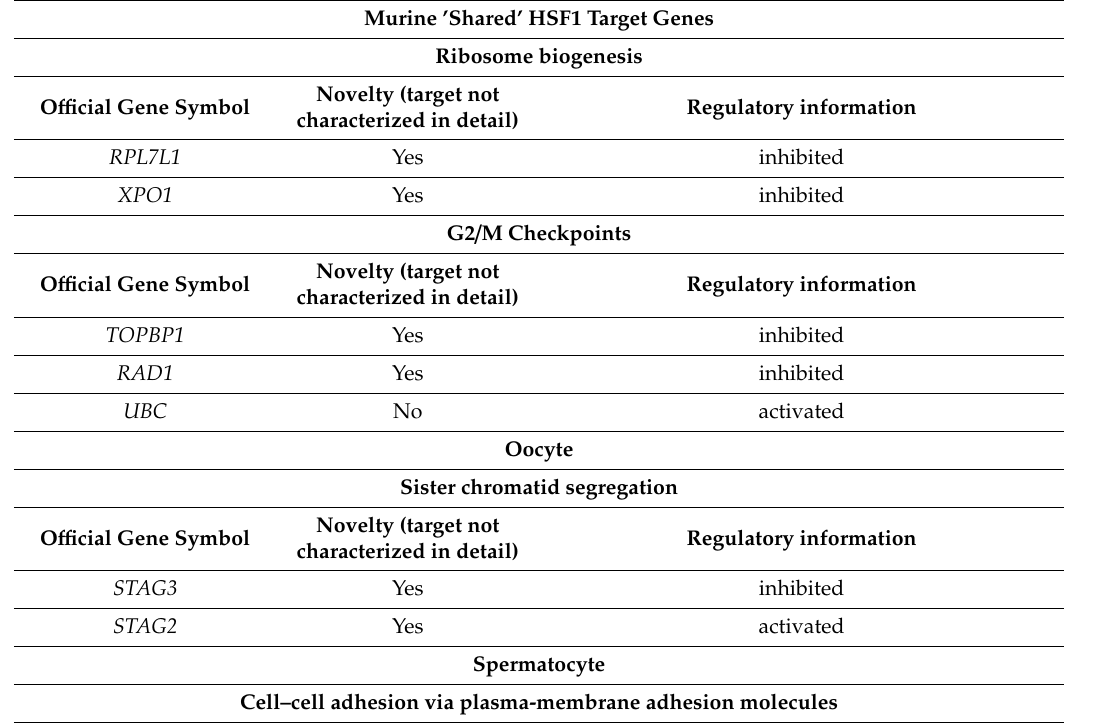
Table 3. Selected list of HSF1 target genes identified in murine cell types, using the HSF1Base.